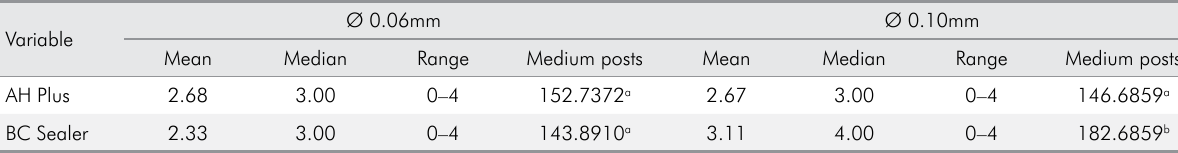
Table 2. Mean, median, range of scores (0–4) and medium posts obtained during analysis of filling of lateral canals, according to diameter (Ø) of artificial lateral canals (p = 0.02).